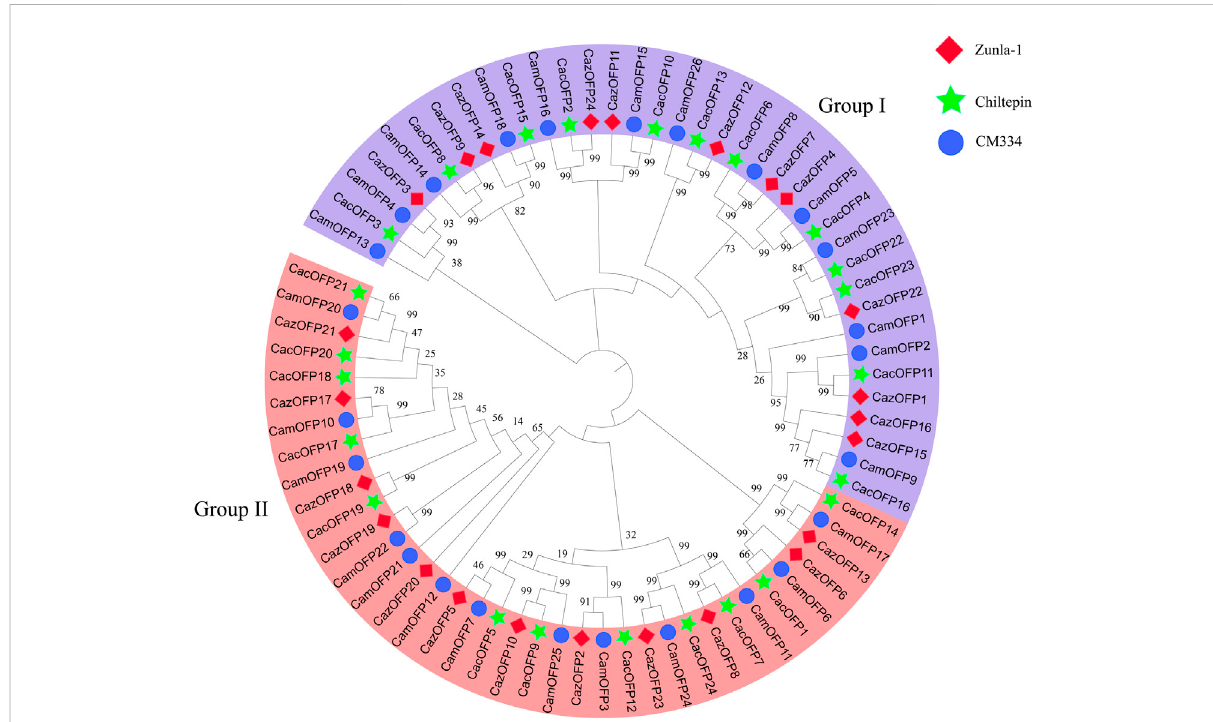
FIGURE 1 Phylogenetic analysis of OFP genes in pepper. Caz: Zunla-1; Cac: Chiltepin; Cam: CM334. The solid diamond with red color represented CazOFP gene of Zunla-1; the solid star with green color represented CacOFP gene of Chiltepin; and the solid circle with blue color represents CamOFP gene of